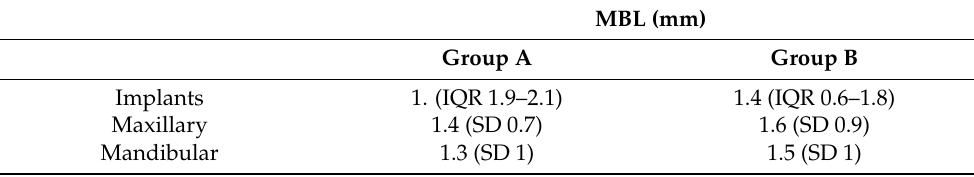
Table 2. MBL comparisons between group A and B.